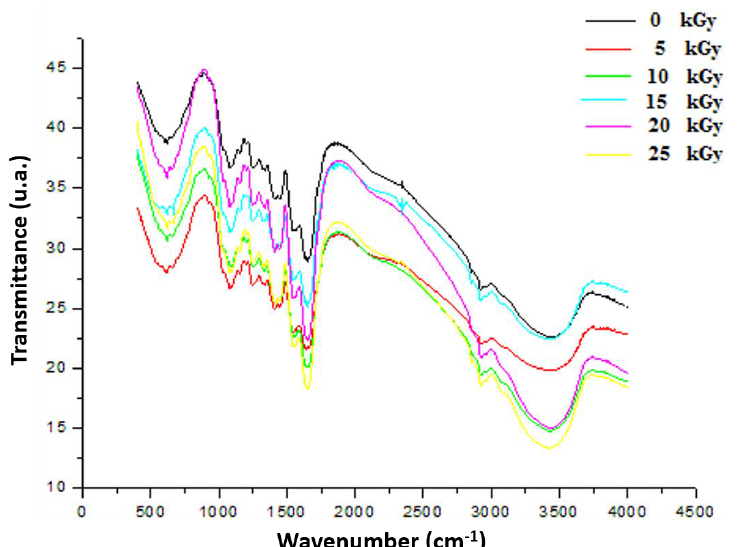
Figure 7. FTIR spectrum of irradiated gelatine – chitosan – Pomegranate (GEL – CH – PP) composite of functional groups with different γ -radiation doses, 5, 10, 15, 20, and 25 kGy, in comparison with control samples (0 kGy).